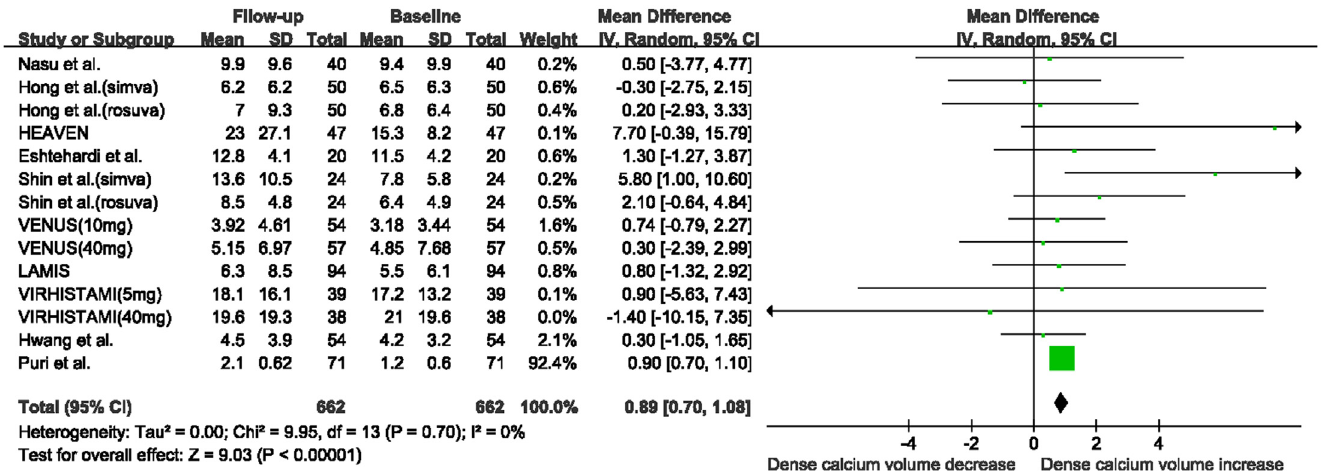
Fig 3. Changes in dense calcium volume between follow-up and baseline with statin therapy. Abbreviations: CI: confidence interval; SD: standard deviation.